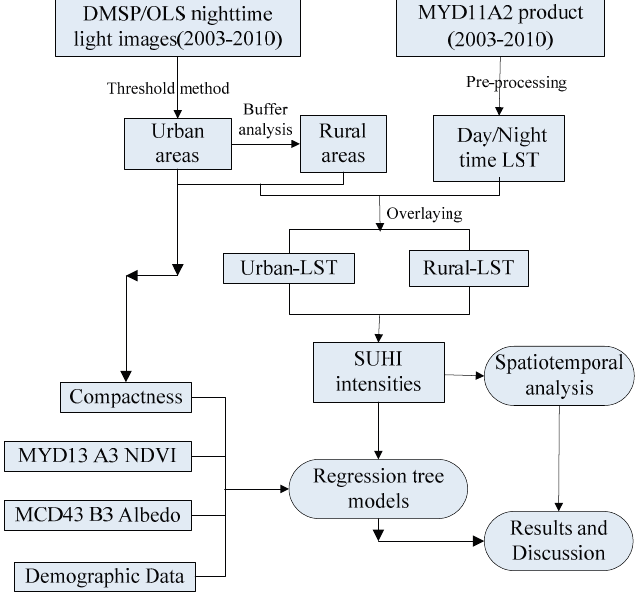
Figure 2. Flowchart describing the research